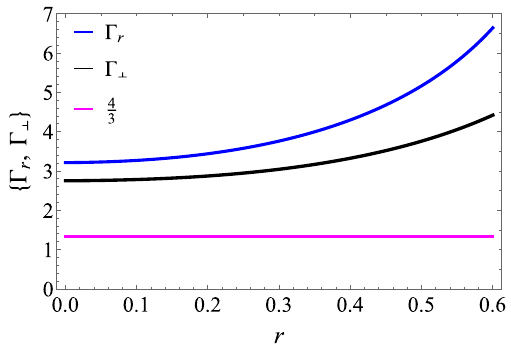
Fig. 2 Adiabatic index showing stability for the anisotropic interior solution case (greater than 4 /